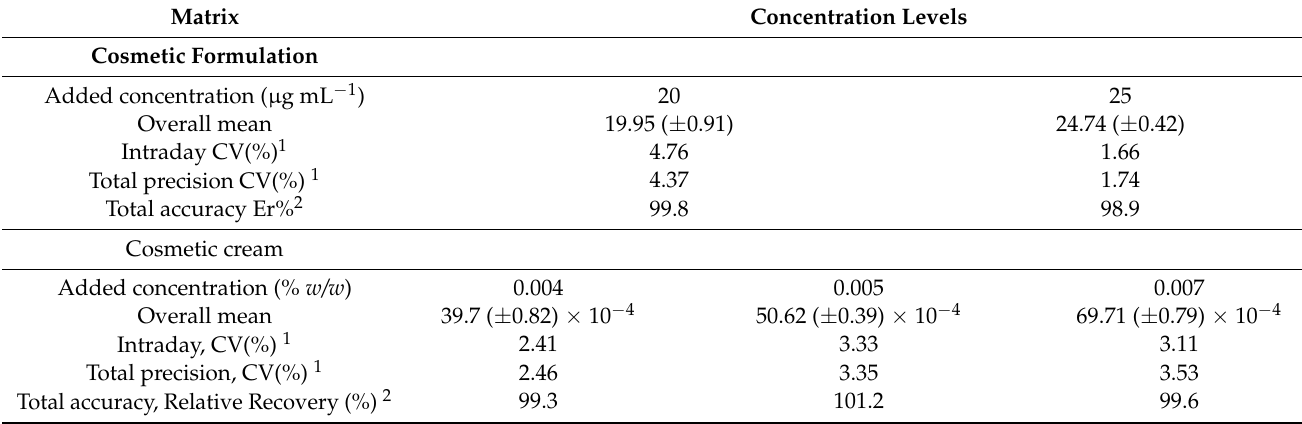
Table 3. Accuracy and precision data of the HILIC-PDA method for the quantitation of acetyl hexapeptide-8 in cosmetic formulation and cosmetic creams ( n = 3 runs in 5